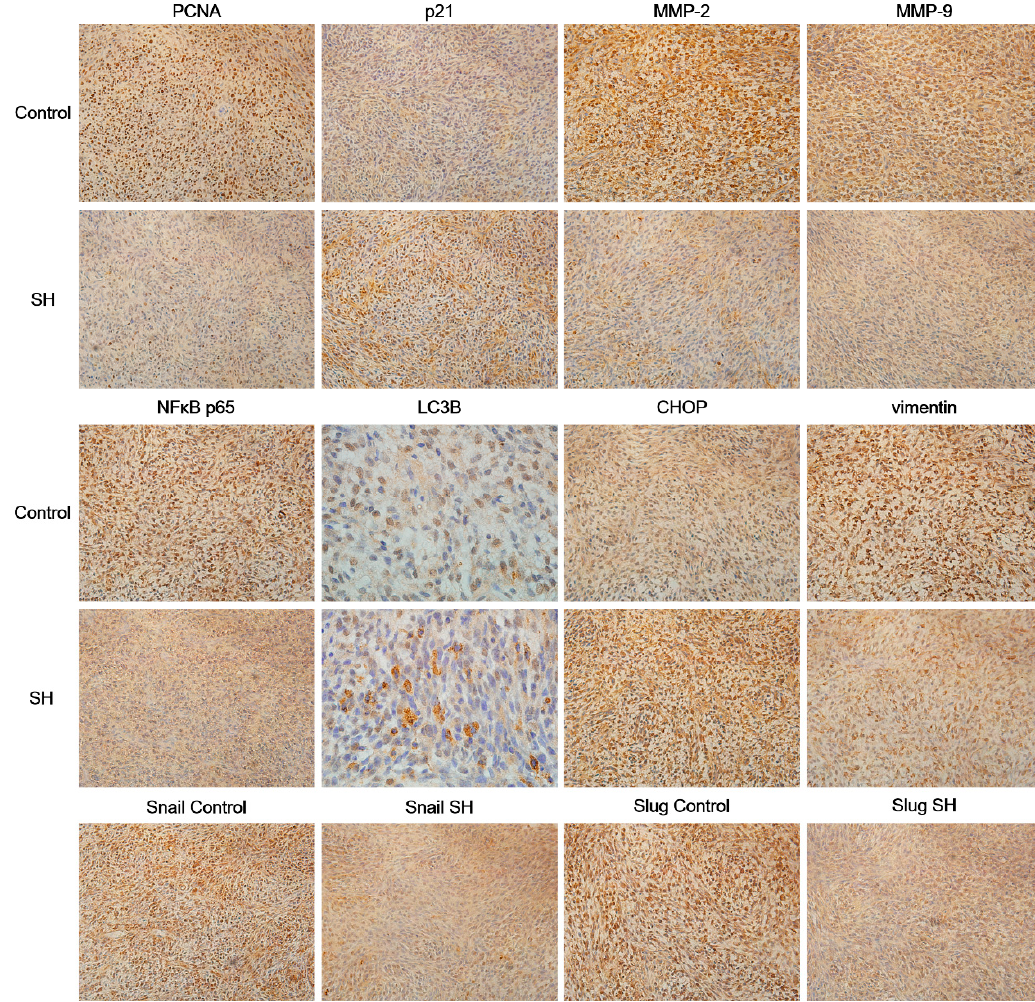
Figure 6. SH regulates the levels of proliferation and metastasis-related proteins in glioblastoma tumors in vivo. Immunohistochemical staining for proliferating cell nuclear antigen (PCNA), p21, MMP-2/-9, NF κ B p65, LC3B, CHOP, vimentin, Snail and Slug in tumor tissue samples treated with SH (75 mg/kg) or physiological saline. The representative overview images of immunohistochemical staining for LC3B were captured at 1000× magnification; all the others were captured at 400× magnification. Each image is representative of n = 7 samples, with similar results.